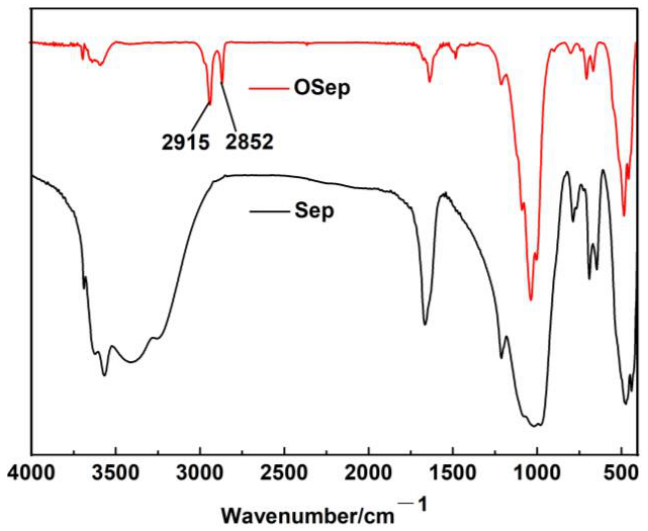
Figure 2. FT-IR spectra of Sep and